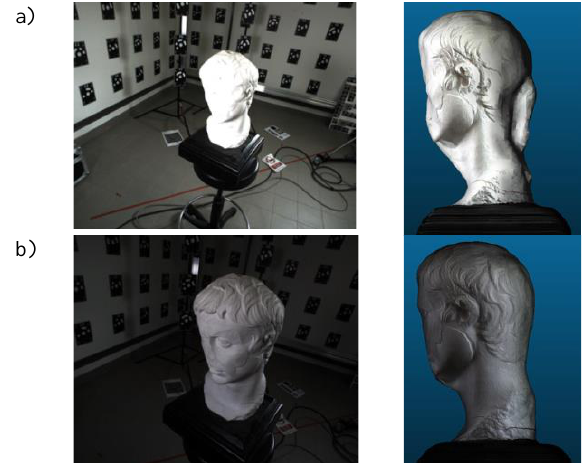
Figure 8. Comparison between in-camera (a) and proposed (b) exposure control algorithm showing one of the recorded images and the corresponding reconstructed 3D mesh. The proposed method (b) is independent of foreground and background scene illumination and thus much more reliable and